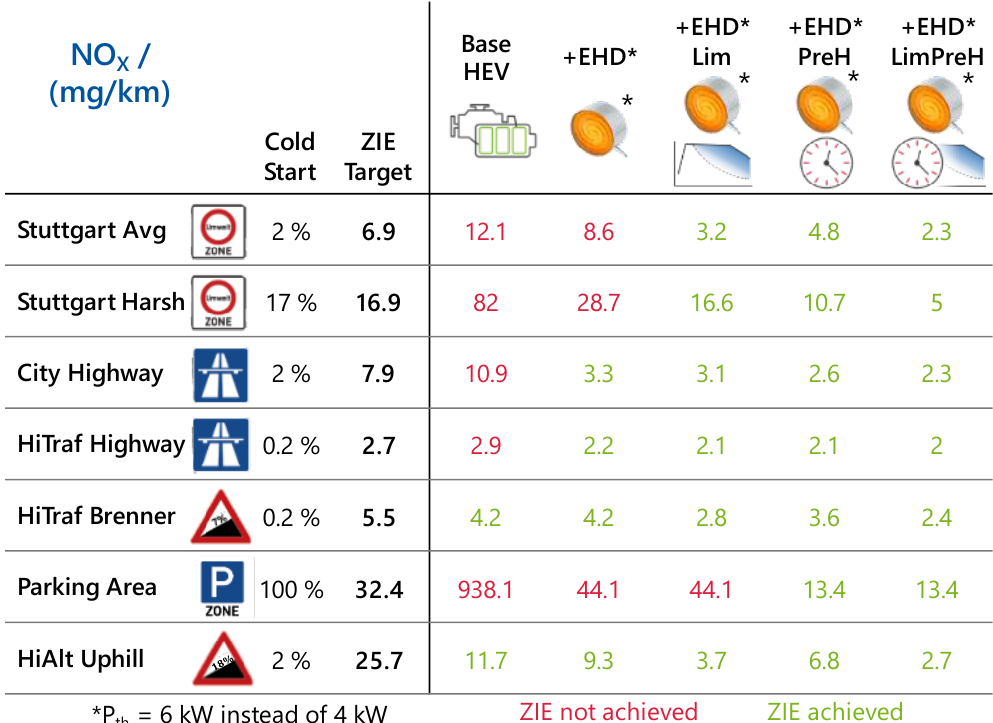
Figure 16. Electrical heater disk+ with 6 kW heating power under Zero-Impact Emissions test conditions.